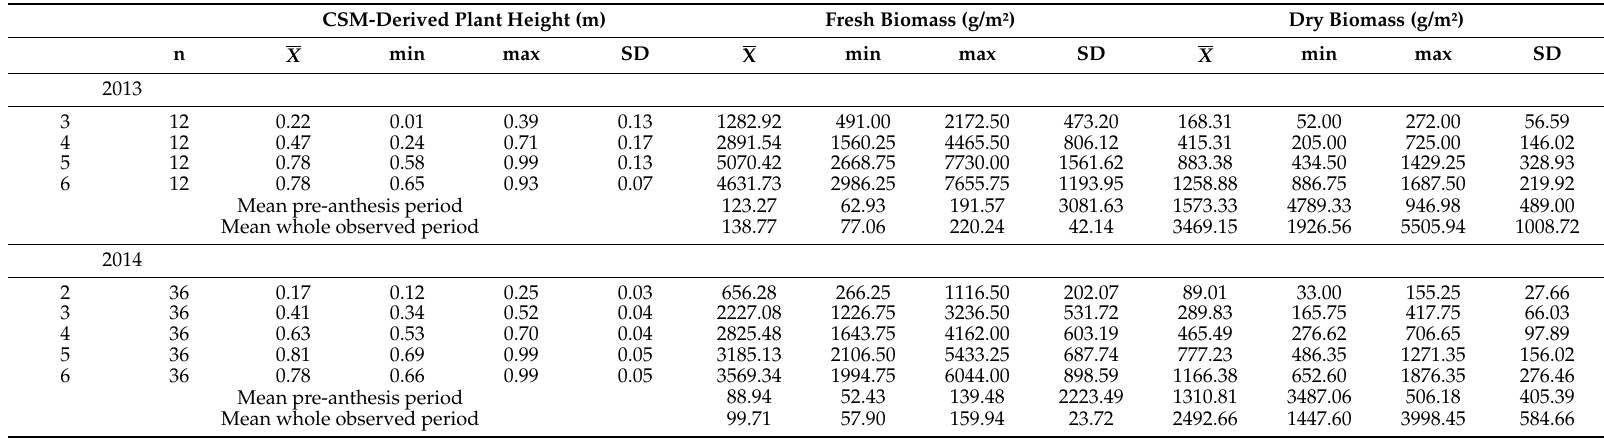
Table 1. Correction of Table 4 [1]. Statistics for the plot-wise averaged CSM-derived plant heights and destructively taken biomass for the reduced data sets of 2013 and 2014 (n: number of samples; X : mean value; min: minimum; max: maximum; SD: standard deviation).